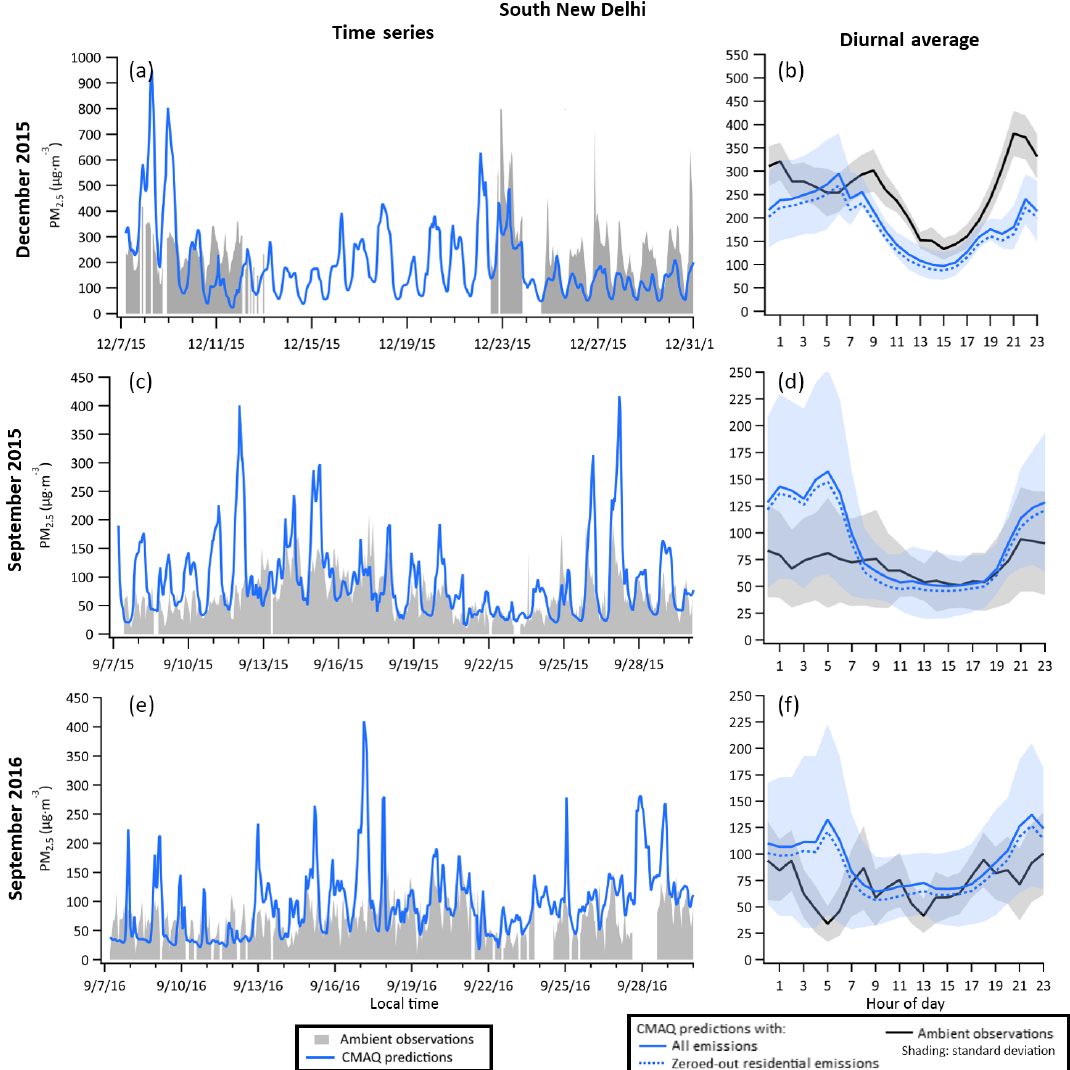
Figure 9. Measured and predicted PM 2 . 5 (a, c, e) and average diurnal cycle (b, d, f) in South New Delhi for 20–31 December 2015 (a, b) and 20–30 September 2016 (c–f) . Here the blue lines correspond to CMAQ predictions of the “total” (solid) and “nonresidential” (dotted) simu- lations. The solid black line represents ambient observations. Standard deviations of the diurnal profiles for observations and predictions are indicated by gray and blue colored shading, respectively. Diurnal profiles were averaged over simulation durations (Table 7). Computations were carried out at 4km